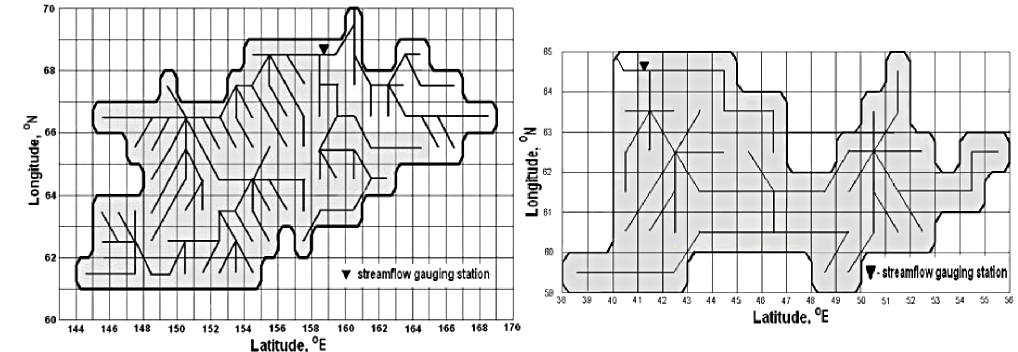
Figure 1. Schematization of the Kolyma (left panel) and the Northern Dvina (right panel) river